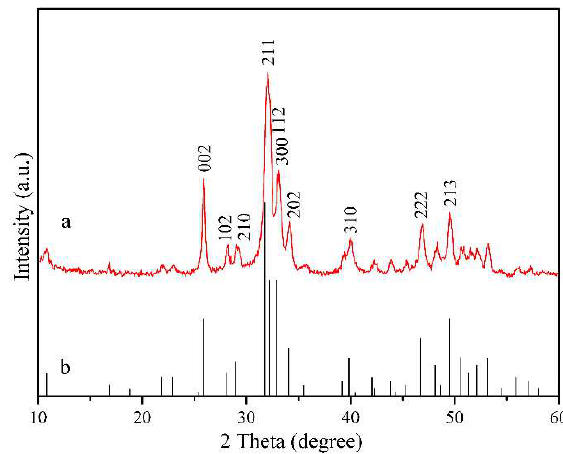
Figure 3. XRD of nHA particles, ( a ) self-made sample; ( b ) standard card.